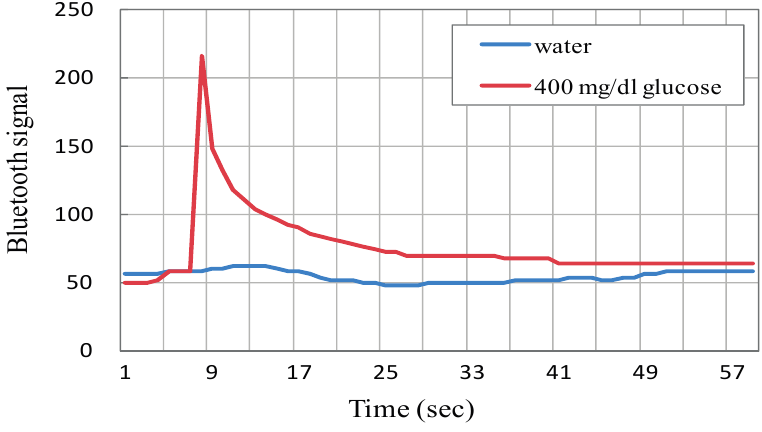
Figure 6. The calibration process for the glucose sensor and bluetooth 4.0 module. ( A ) The relationship between transducing voltage vs. input resistance in the circuit, which may simulate different glucose concentrations in solutions; ( B ) The logged bluetooth signal vs. input resistance standing for different glucose solutions in the transducing circuit.